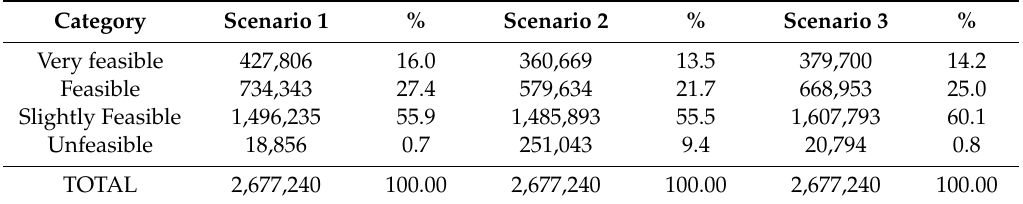
Table 7. Areas (in km 2 ) and percentages for each category in each produced